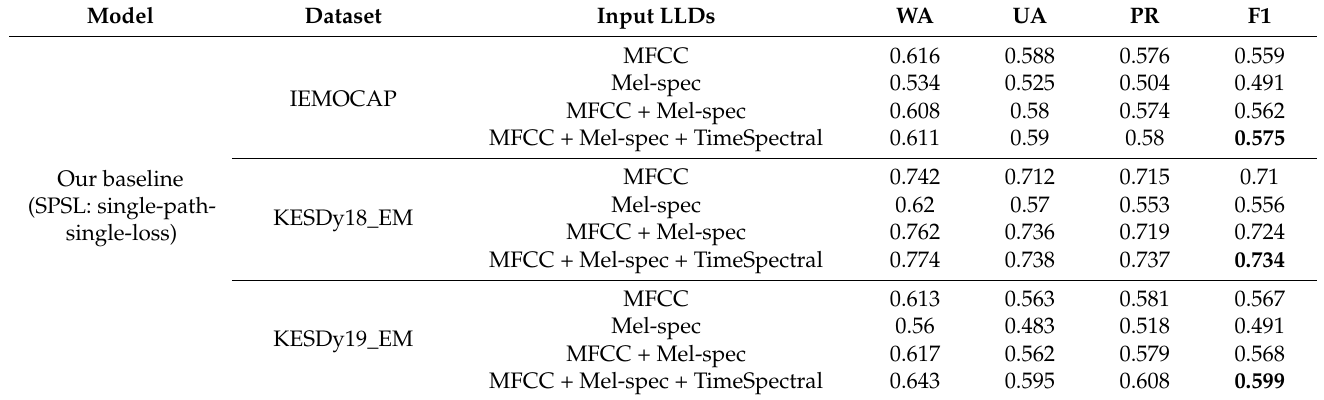
Table 3. Performance of the baseline BLSTM-based SER model according to the input low-level descriptions (LLD) feature set in SER datasets.